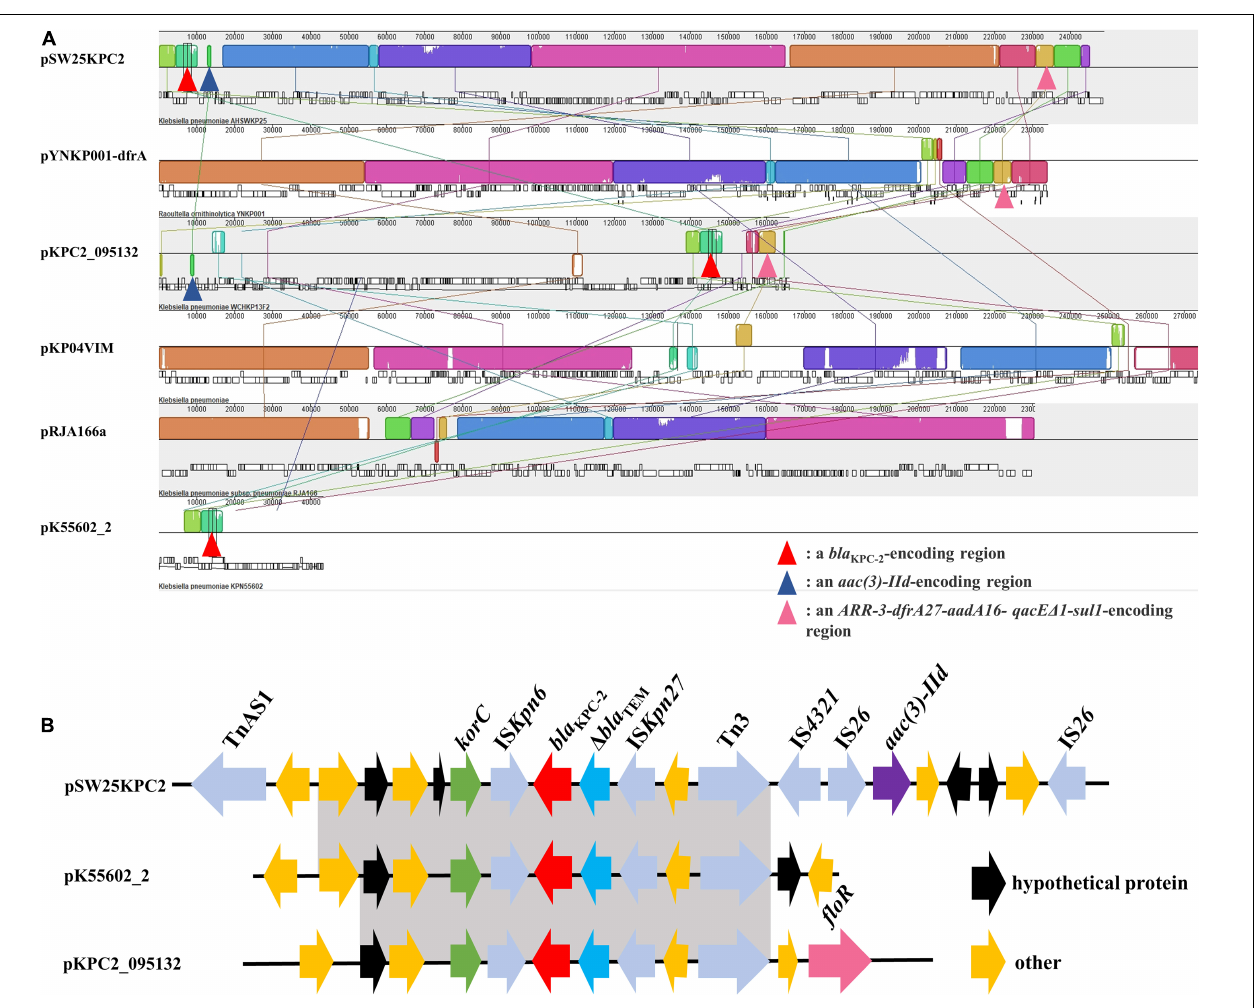
FIGURE 4 | (A) Mauve alignment between pSW25KPC2 and other five plasmids. The grids of the same color represent collinear areas and are connected by lines. The blank area in the grid indicates that the sequences are incompletely aligned. (B) Comparison of genetic elements surrounding bla KPC − 2 between pSW25KPC2 and plasmids carrying bla KPC − 2 . Gray areas represent homologous portions between